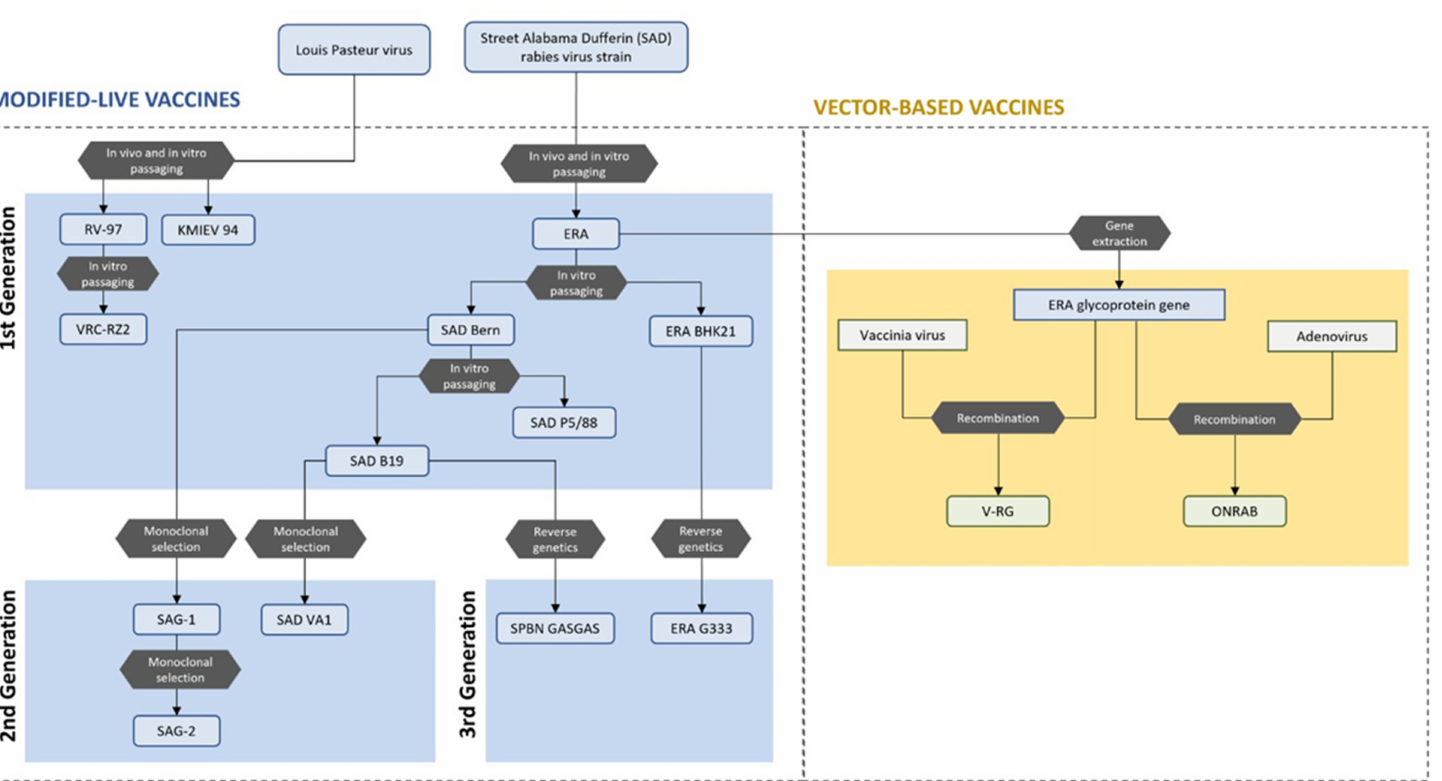
Figure 1. Diagram showing the parental derivation of ORVs that have been licensed for use in wildlife in countries within Europe, Asia or North America. First generation modified-live vaccines were derived from SAD rabies virus strain in 1935. Second and third generation of modified-live vaccines were developed through monoclonal selection and reverse genetics in 1980s and 1990s. Vector-based vaccines were developed from ERA strain by gene extraction and recombination with vaccinia and adenoviruses in the